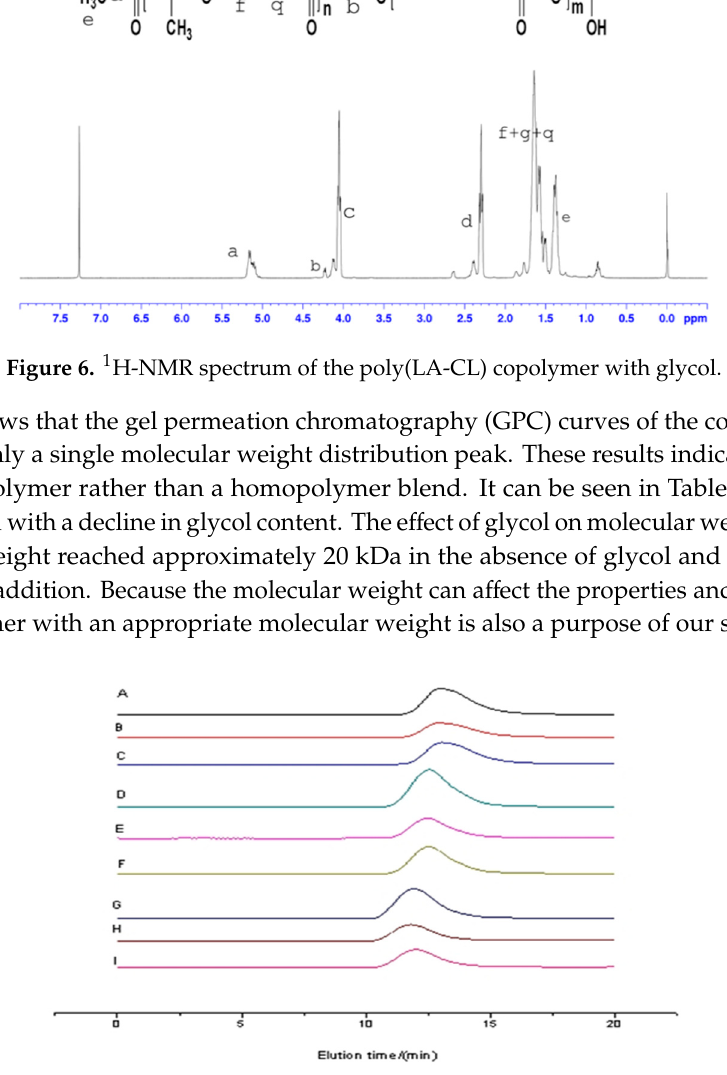
Figure 5. Protonic nuclear magnetic resonance ( 1 H-NMR) spectrum of the poly(lactide- ε - caprolactone) (P(LA-CL)) copolymer without glycol.